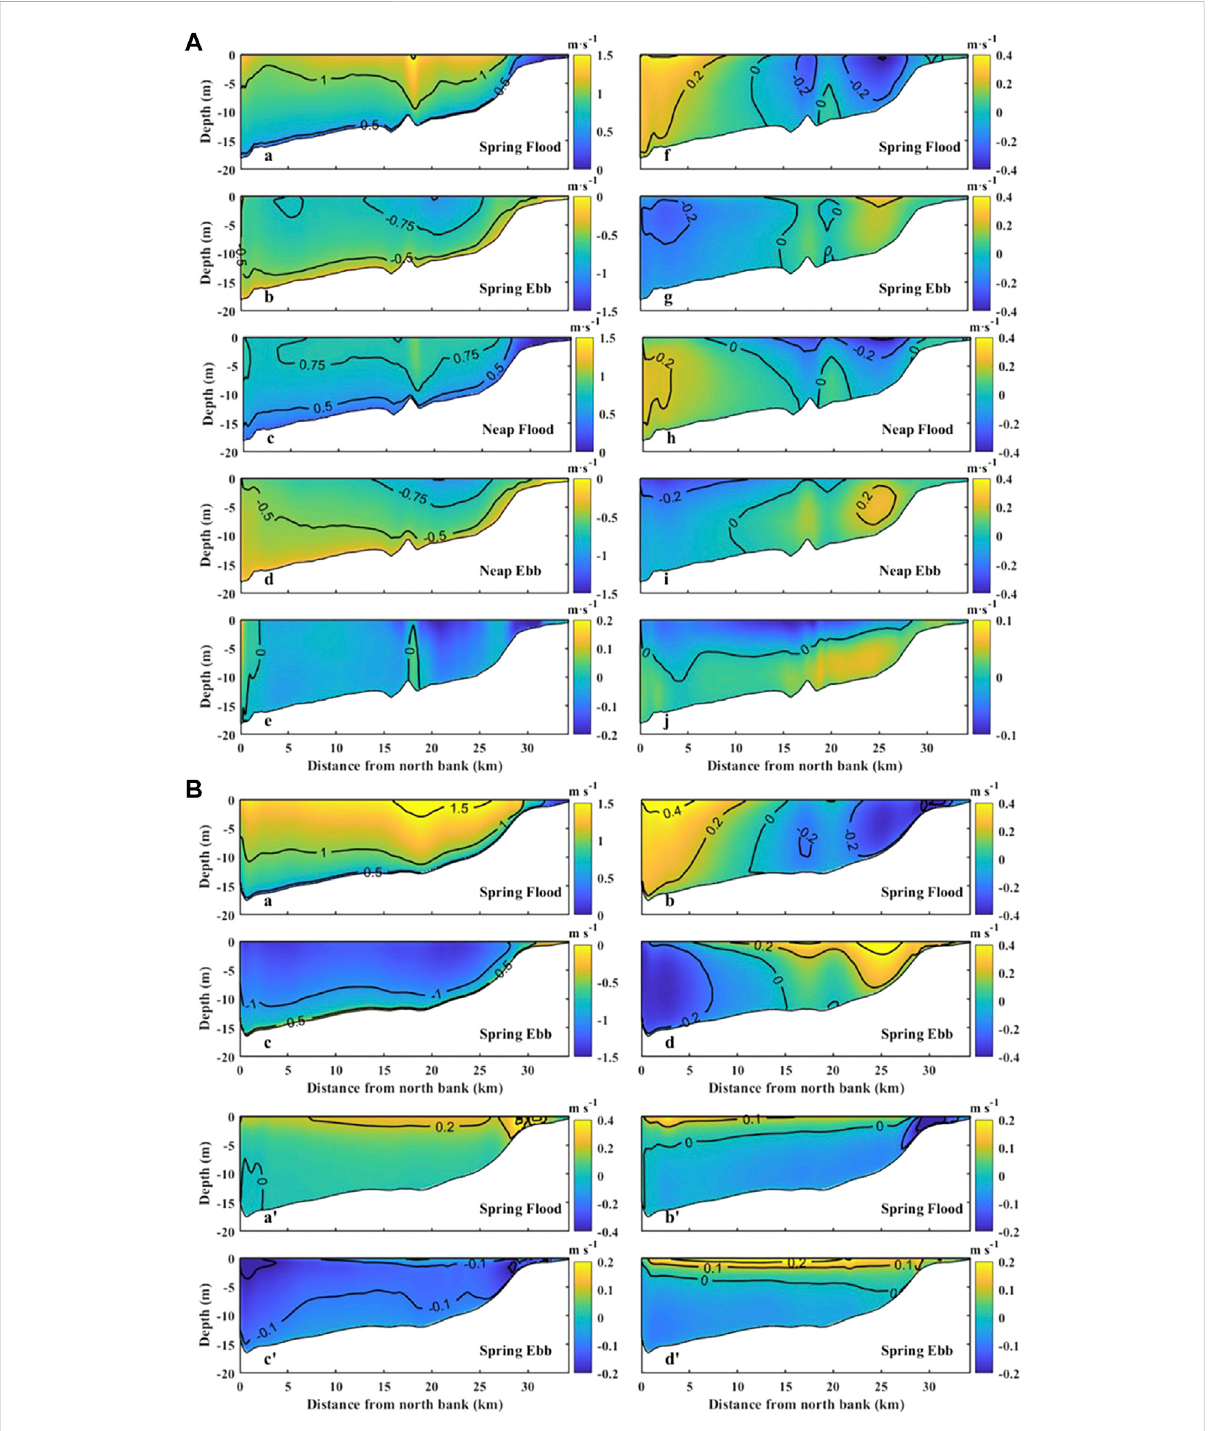
FIGURE 8 (A) Along-estuarine (left column) and lateral currents (right column) in section C1 (calm weather, 1 – 30 March 2013, GMT) (a,f) are for spring fl ood tide. (b,g) are for the spring ebb tide. (c,h) are for neap fl ood tide. (d,i) are for the neap ebb tide. (e,j) are for the averaged along-estuarine and lateral currents in 1 month. (B) Along-estuarine and lateral currents in section C1 (Typhoon Mitag). (a,b) are for spring fl ood tide and (c,d) is the same as (a,b) except for the spring ebb tide. Positive values indicate landward or southward direction. (a ’– d ’ ) are the same as (a – d) except for the differences of spring fl ood currents at section C1 between the test with Typhoon Mitag and the test with only tidal